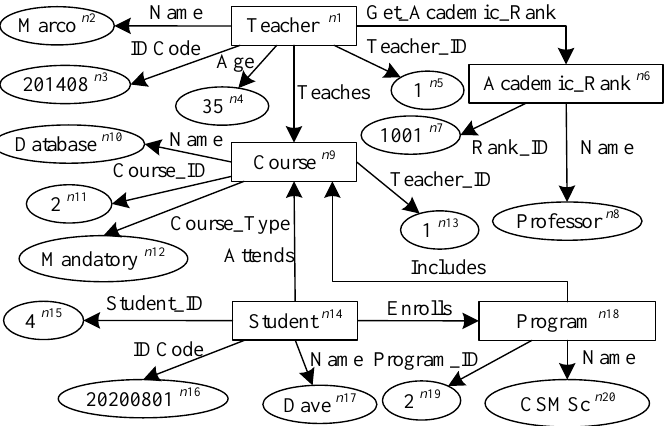
Figure 3. W-Instance of Mini University data